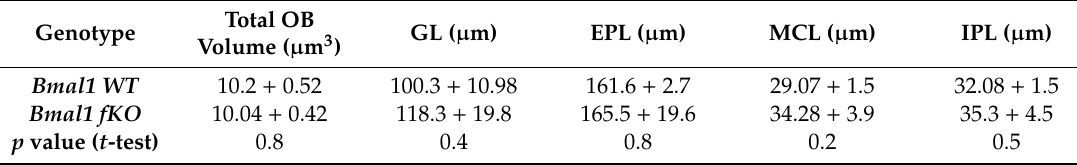
Table 1. Volume and cytoarchitecture of the olfactory bulb (OB) in Bmal1 WT ( n = 3) and Bmal1 fKO mice ( n = 3) based on cresyl violet-stained sections. The thickness of the following layers was analyzed separately: external plexiform (EPL), mitral cell (MCL), internal plexiform (IPL), and glomerular layer (GL). Total OB GL ( µ m) EPL ( µ m) MCL ( µ m) IPL ( µ m) Genotype Volume ( µ m 3 ) Bmal1 WT 10.2 + 0.52 100.3 + 10.98 161.6 + 2.7 29.07 + 1.5 32.08 + 1.5 10.04 + 0.42 118.3 + 19.8